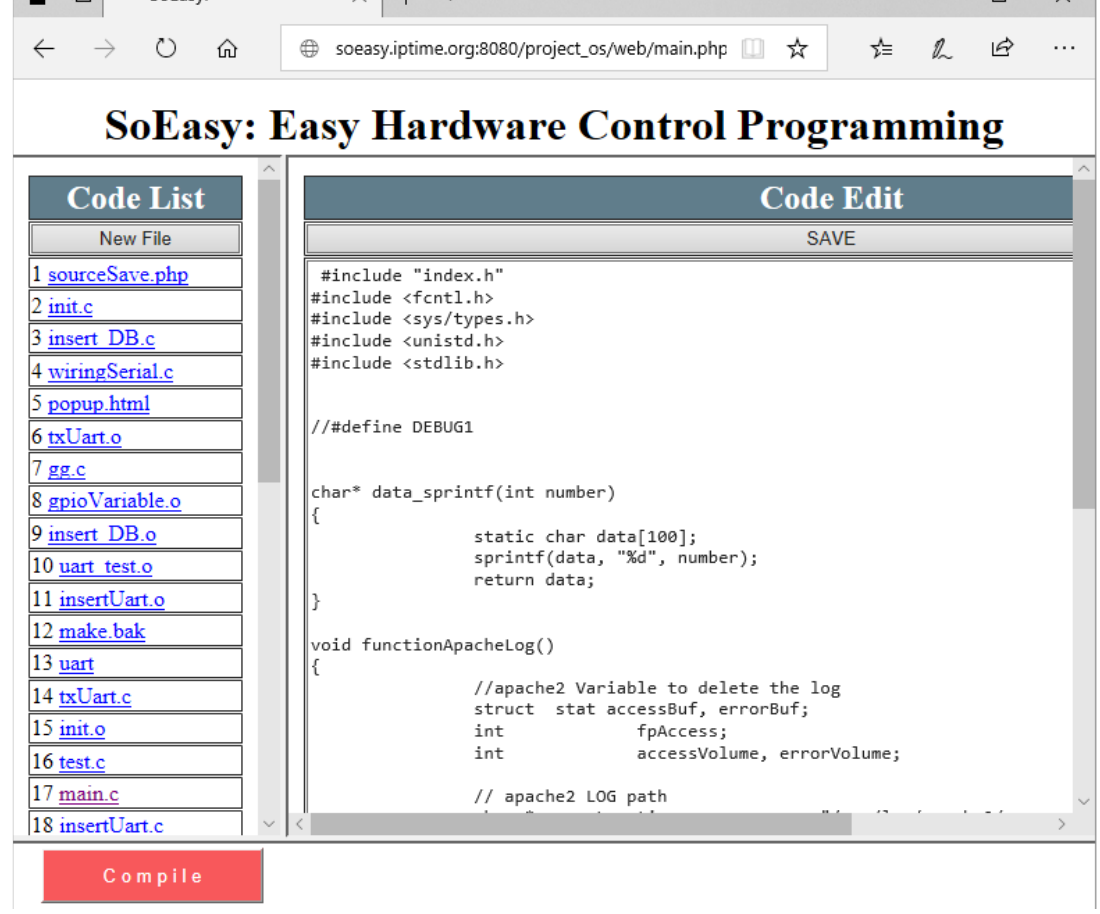
Figure 5. Code Editing function in a Web